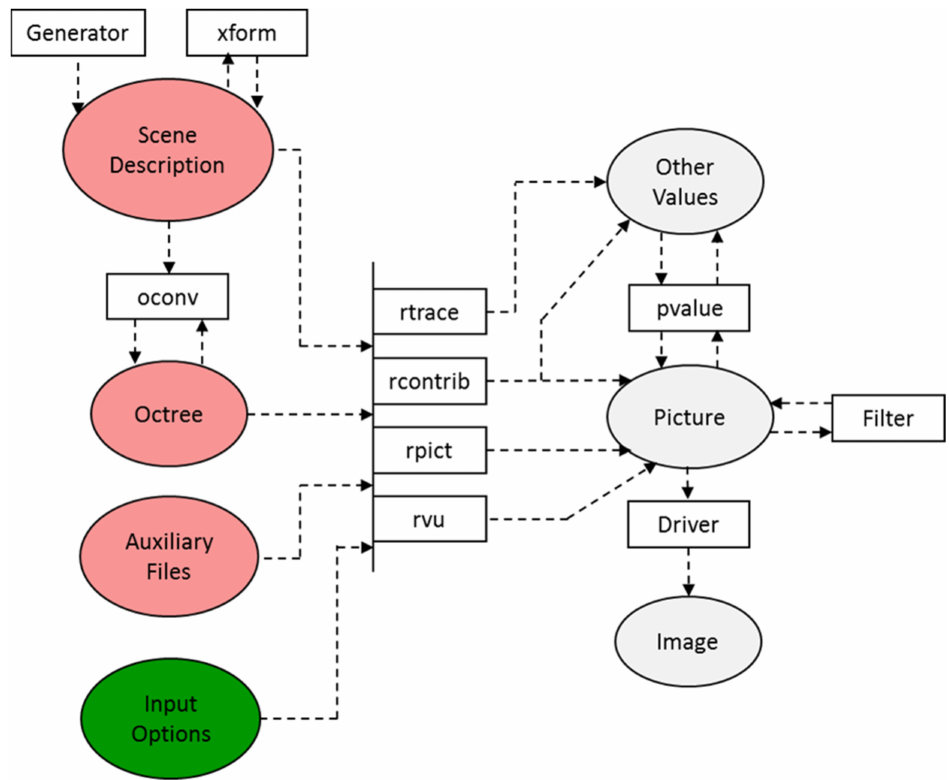
Figure 2. Schematic diagram for a conventional RADIANCE simulation. The values in rectangles refer to individual executable programs. The programs ‘Generator’, ‘Driver’ and ‘Filter’ refer to generic third-party programs that interface with RADIANCE inputs and